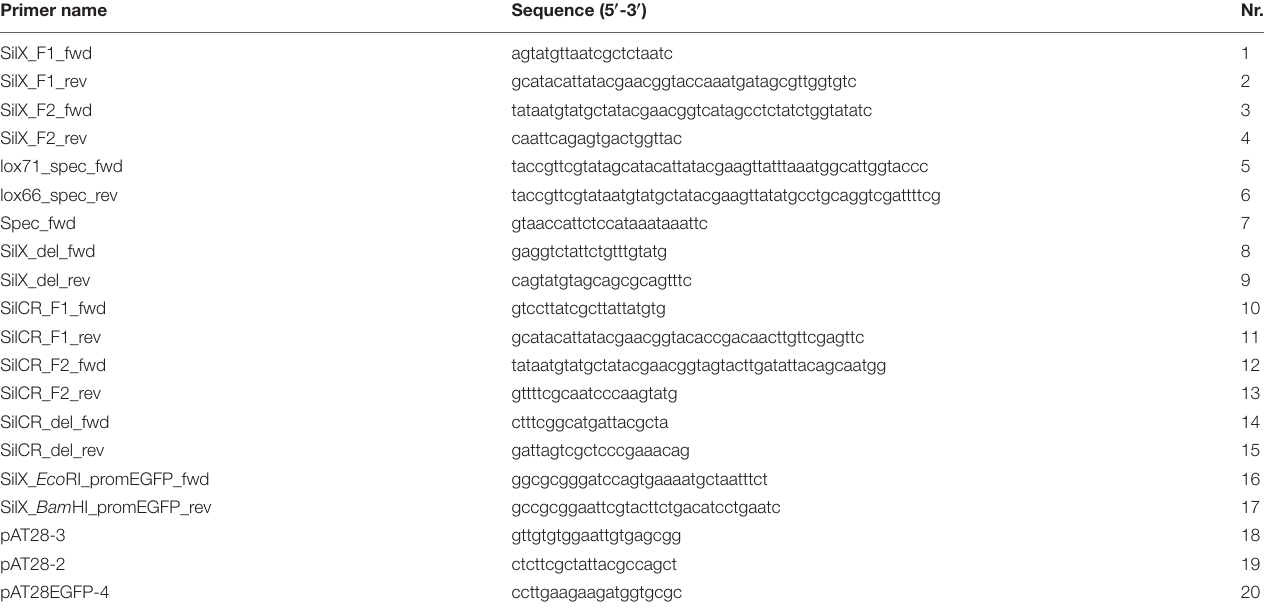
TABLE 2 | Primers used in this